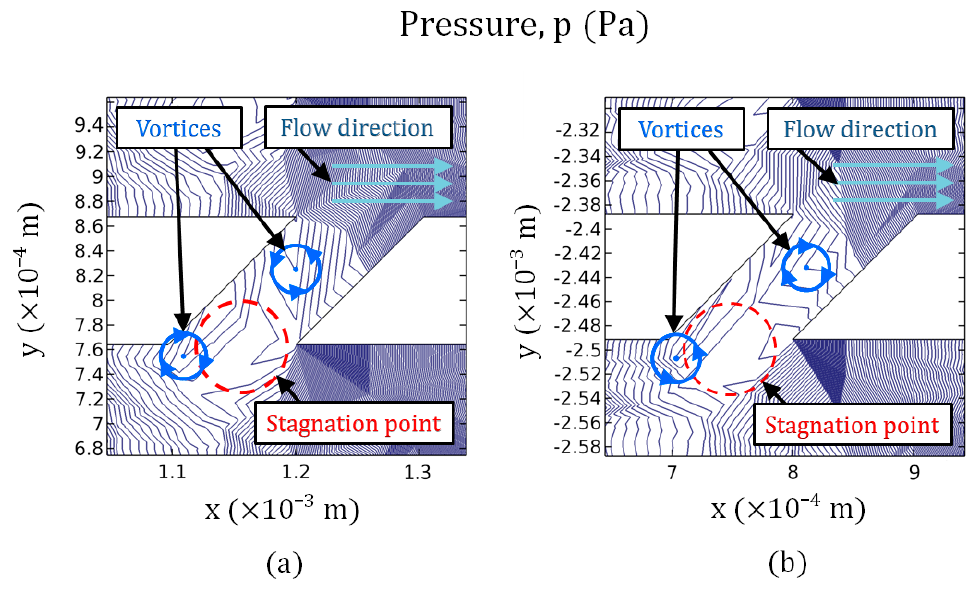
Figure 12. Close-up view of pressure contours over midplane (z = 0) of the heat sinks ( a ) in the vicinity of x = 1.20 × 10 − 3 m and y = 8.20 × 10 − 4 m for the heat sink A (regular trapezoidal secondary flow) and ( b ) in the vicinity of x = 8.0 × 10 − 4 m and y = − 2.44 × 10 − 3 m for the heat sink B (parallel secondary flow).